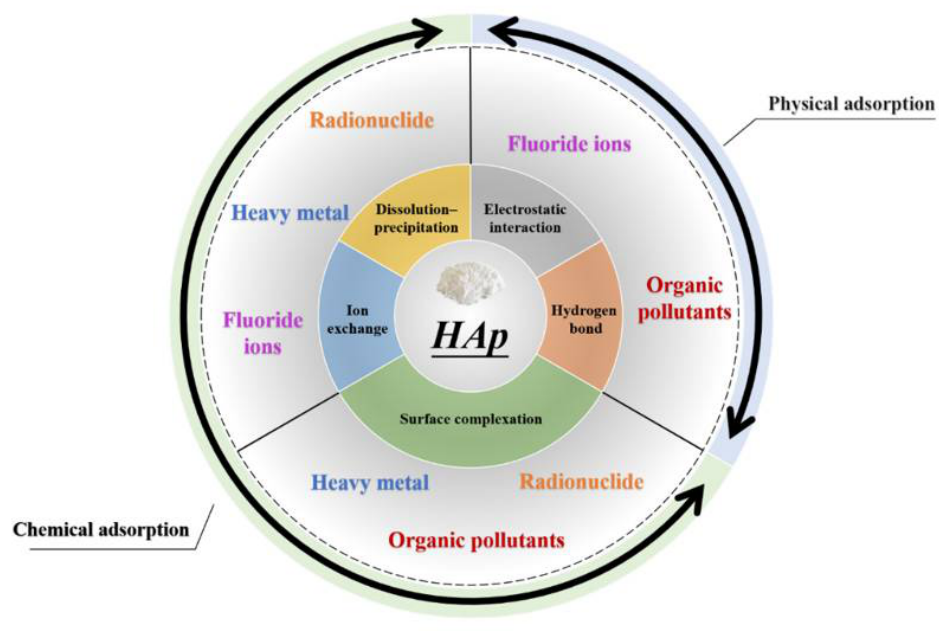
Figure 1. Adsorption mechanism of hydroxyapatite and its application.